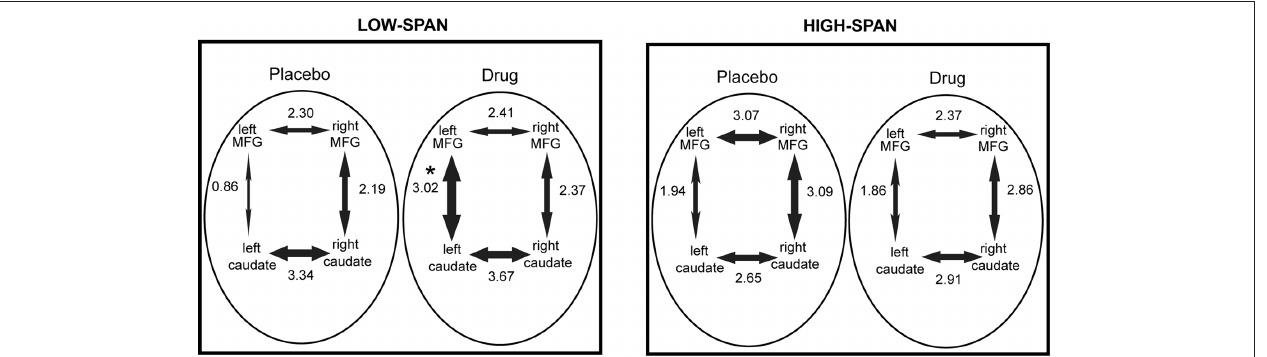
each pair of regions is indicated alongside each arrow and the thickness of the arrows is scaled proportionally to this value. Asterisk indicates p < 0.05, for significant difference between placebo and drug session, corrected for